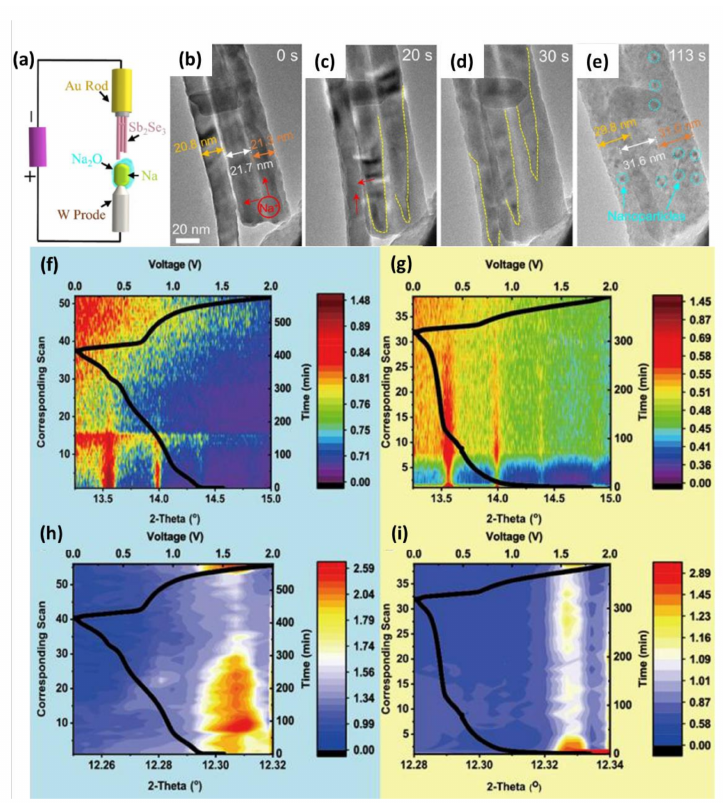
Figure 7. ( a ) Schematic illustration of the experiment setup for in situ electrochemical sodiation and desodiation. ( b – e ) Chronological TEM images show morphological evolution of three Sb 2 Se 3 nanowires during the first sodiation process. Comparison of contour plots of the operando syn- chrotron X-ray powder diffraction with superimposed voltage profiles shown for selected ranges of ( f ) multi-shell structured Sb 2 S 3 , ( g ) pristine Sb 2 S 3 and their corresponding discharging products ( h , i ) whereby Sb signals were